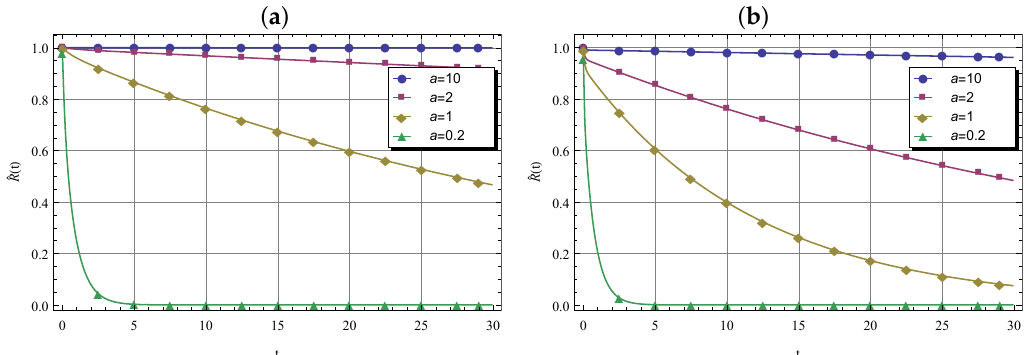
Figure 4. Functions ˆ R ( t ) for LN ( a ) and PH ( b ) distributions versus a .